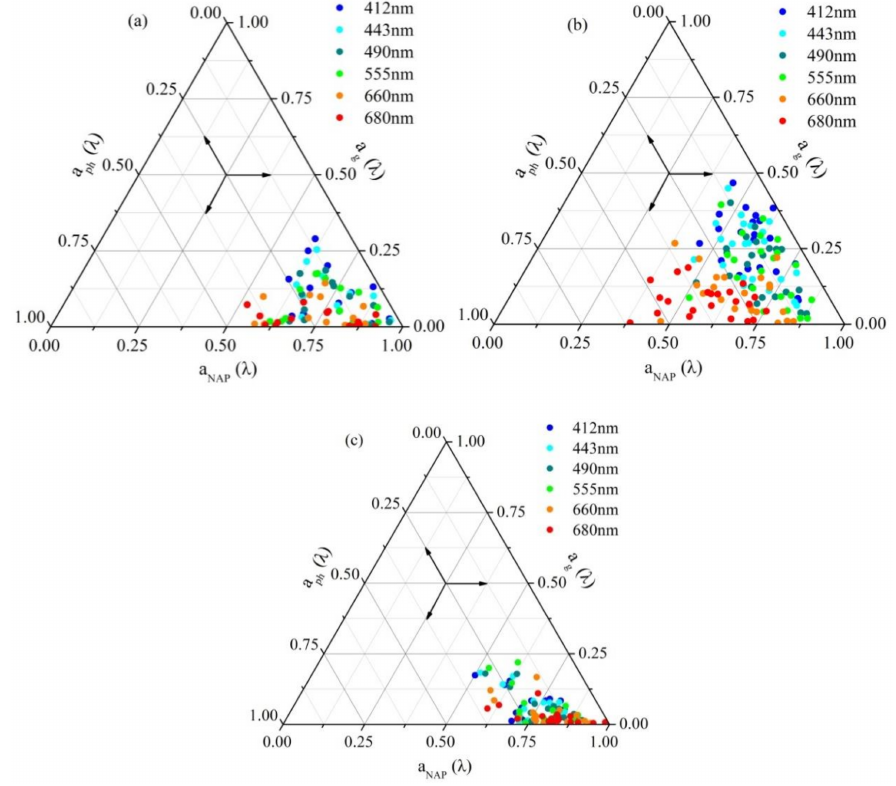
Figure 11. Ternary plots presenting the relative contribution of absorption by non-algal particles, phytoplankton pigments, and CDOM to total absorption by non-water constituents at different wavelengths at: ( a ) Station P1 (N = 15); ( b ) Station P2 (N = 23); and ( c ) Station P3 (N = 16). Different colors represent different